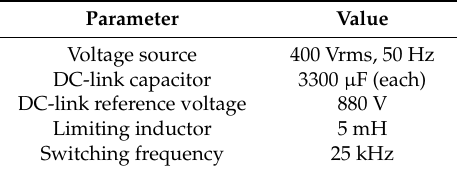
Table 3. Proposed parameters for SAPF.